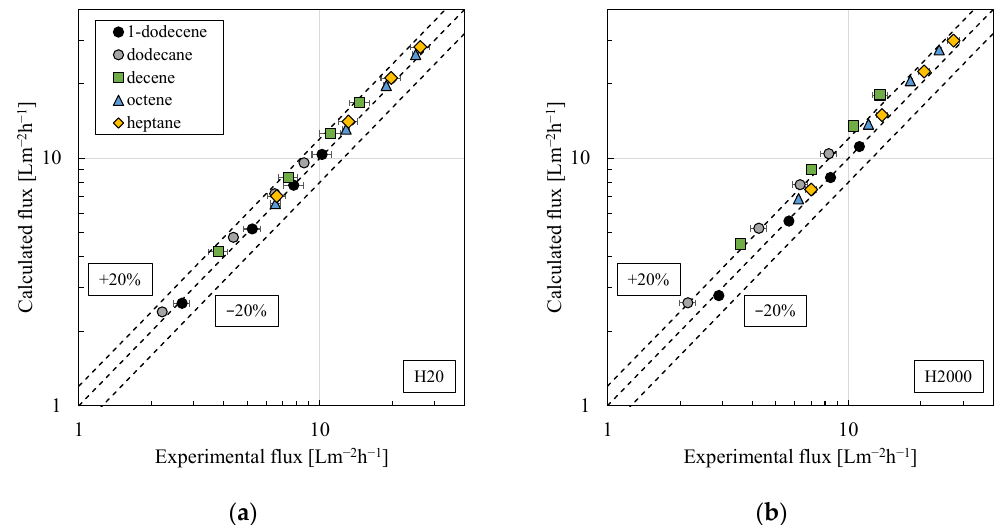
Figure 11. Calculated flux vs. experimental flux for w/o PEs prepared using different organic solvents and stabilized by particle type ( a ) H20 or ( b ) H2000. For the model fit (solution–diffusion model combined with a resistance in series model, compare Equation (7)), the experimental results of 1-dodecene were used. All pressure stepping experiments were conducted at least in duplicate and mean values are shown. Error bars represent the standard deviation. Where not visible, error bars are smaller than the symbol